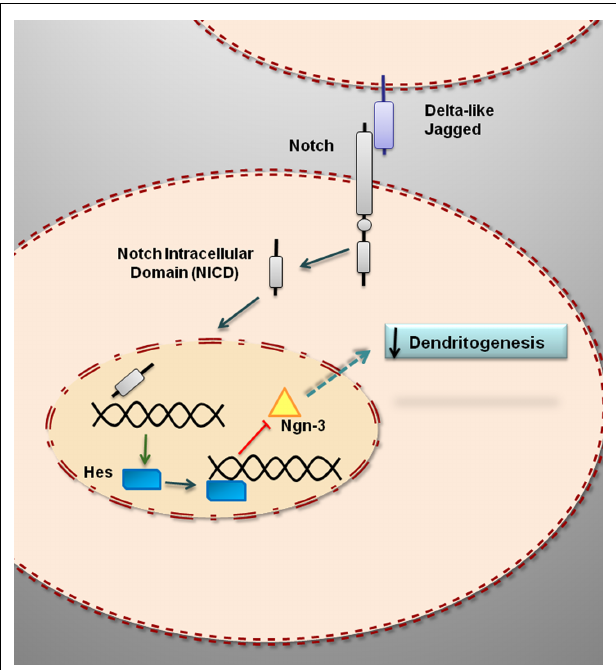
FIGURE 1 | Notch signaling represses dendritogenesis in developing hippocampal neurons by downregulating the expression of neurogenin 3. The binding of Notch ligands (Delta-like, Jagged) results in the cleavage of Notch and the release of an active intracellular domain that is translocated to the cell nucleus where it enhances the transcription of target genes, such as Hes1, that repress the transcription of Ngn3. Ngn3 encodes for a protein, neurogenin 3, which promotes dendritogenesis.